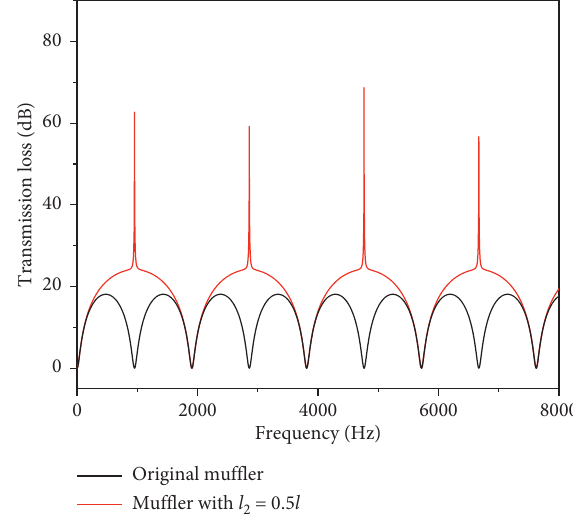
Figure 9: Transmission loss of the side outlet muffler and the original muffler ( l 2 � 0.5 l